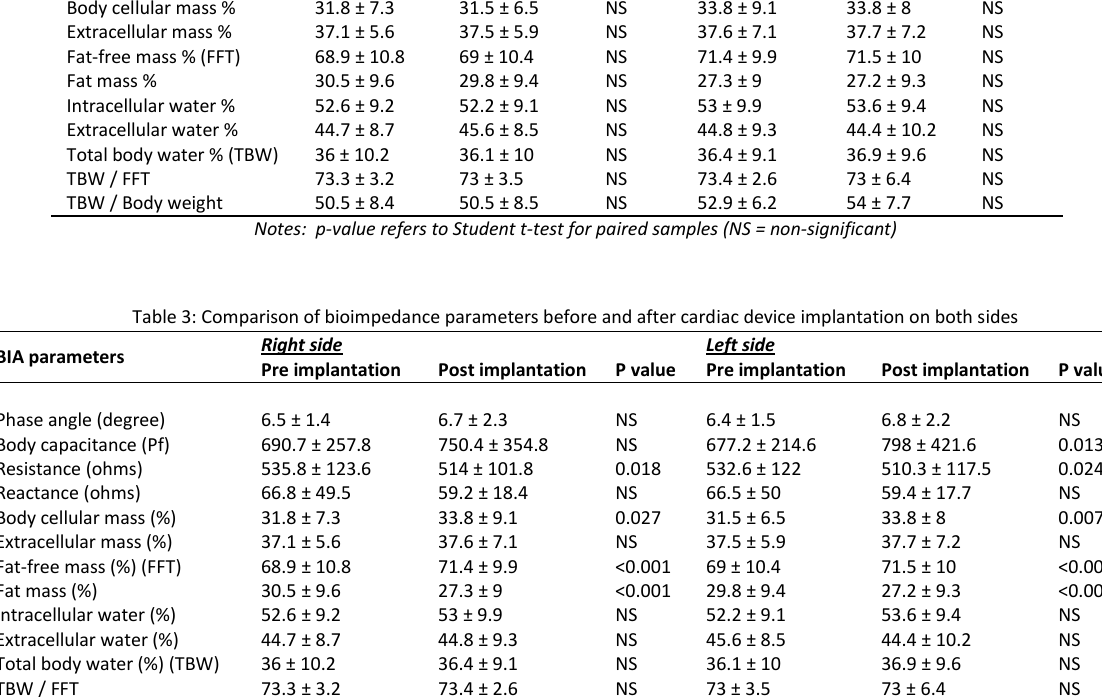
Table 2: Comparison of bioimpedance parameters by body sides before and after cardiac device implantation Pre implantation Post implantation BIA parameters Right side Left side P value Right side Phase angle (degree)